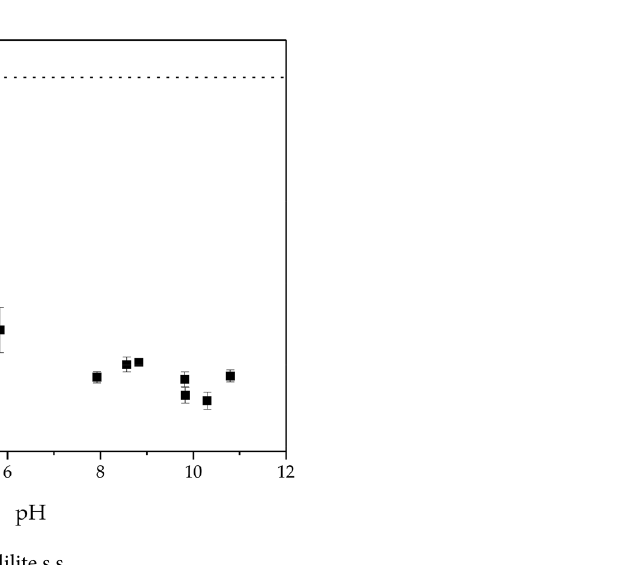
Figure 12. ( a ) IR spectra of LiAlO 2 , Sodium oleate and LiAlO 2 treated in sodium oleate solution. ( b ) IR spectra of samples obtained after the desorption experiment: stirred at a rate of 500 rpm without washing; stirred at 500 rpm with washing; stirred at 1000 rpm with washing.